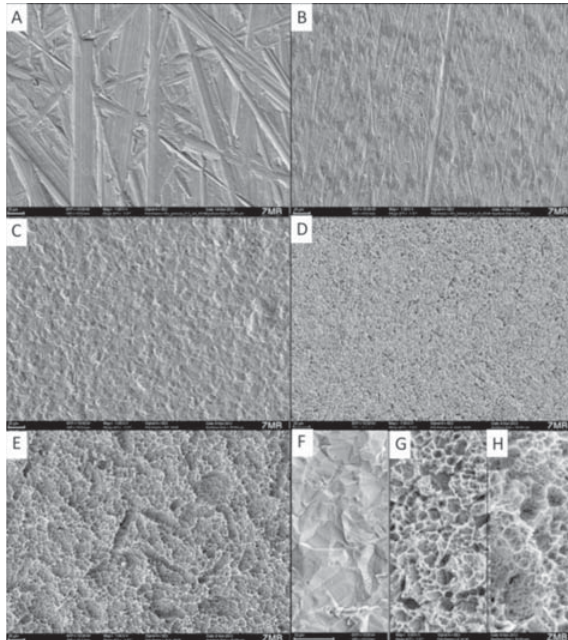
Figure 2- Scanning electron microscopy images of the (cid:9)(cid:6)’’(cid:8)(cid:20)(cid:8)(cid:7)(cid:25)(cid:10)(cid:25)(cid:6)(cid:25)(cid:3)(cid:7)(cid:6)(cid:29)(cid:17)(cid:10)(cid:21)(cid:29)(cid:20)’(cid:3)(cid:4)(cid:8)(cid:21)(cid:10)(cid:3)(cid:25)(cid:10)(cid:17)(cid:3)(cid:19)(cid:7)(cid:6)9(cid:4)(cid:3)(cid:25)(cid:6)(cid:26)(cid:7)(cid:21)(cid:10)(cid:26)’(cid:10)$(cid:13)(cid:13)<(cid:10)=?JKQ(cid:10) and 1,000x (E-G), respectively. A: machined Sa>0.2 μm;